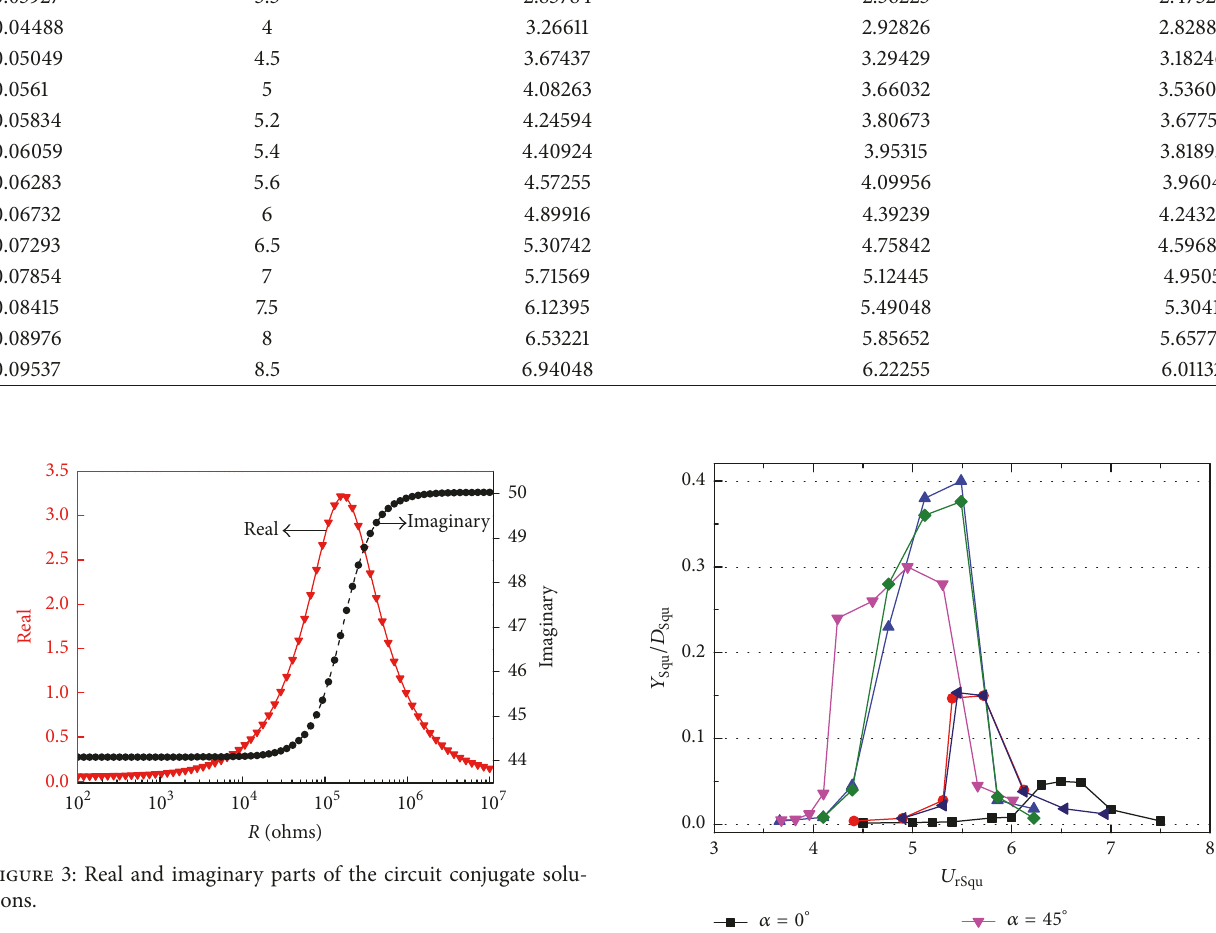
5.3.1. 𝛼 = 0 ∘ . The lock-in region is from 𝑈 𝑟 squ = 6.3 to the end of 𝑈 𝑟 squ = 6.7 , and the maximum amplitude is 𝑌 squmax / 𝐷 squ = 0.05, which appeared at Figure 4. In order to see more clearly about the